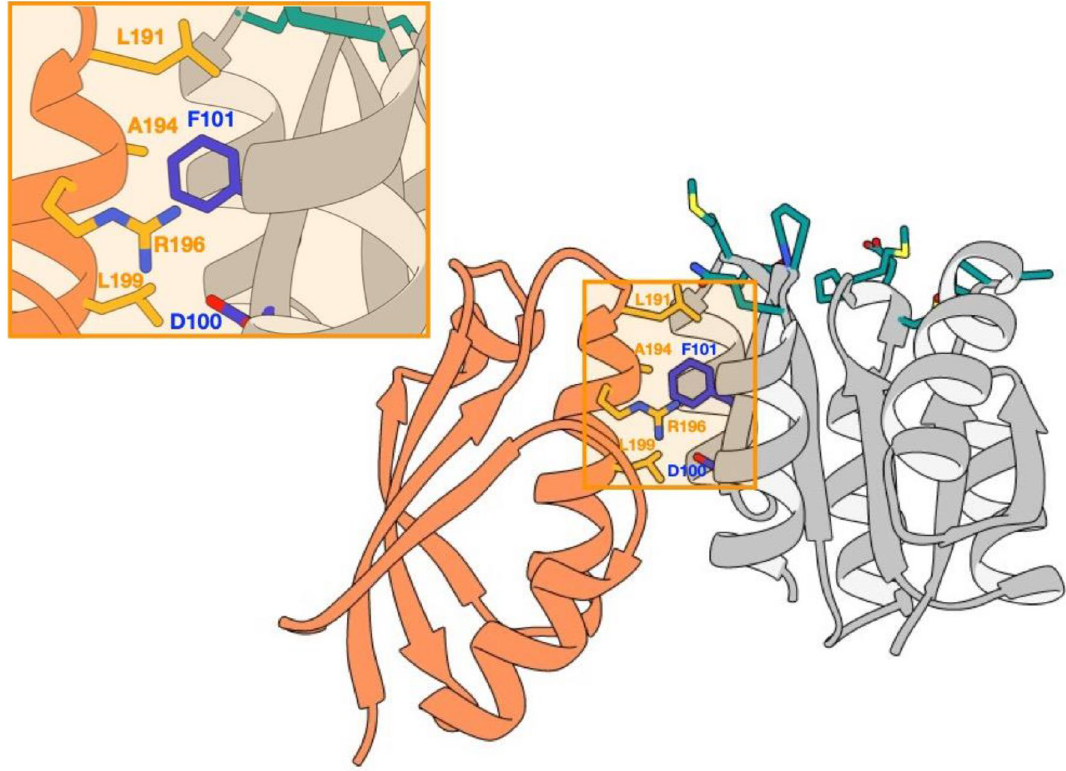
Figure 3. Complex between CheY and its biological partner the P2 domain of CheA. In the crystallographic structure of the CheY/P2 complex of T. maritima (PDB code: 1U0S), P2 protein (left) is shown in orange, CheY protein (right) is represented in grey and the randomized residues in cyan stick in the four exposed loops as in Fig. 1a. The residues involved in the interaction between P2 and CheY are highlighted in yellow stick for the P2 domain (L191, A194, R195 and L198) and in dark blue for CheY (D100 and F101) 47